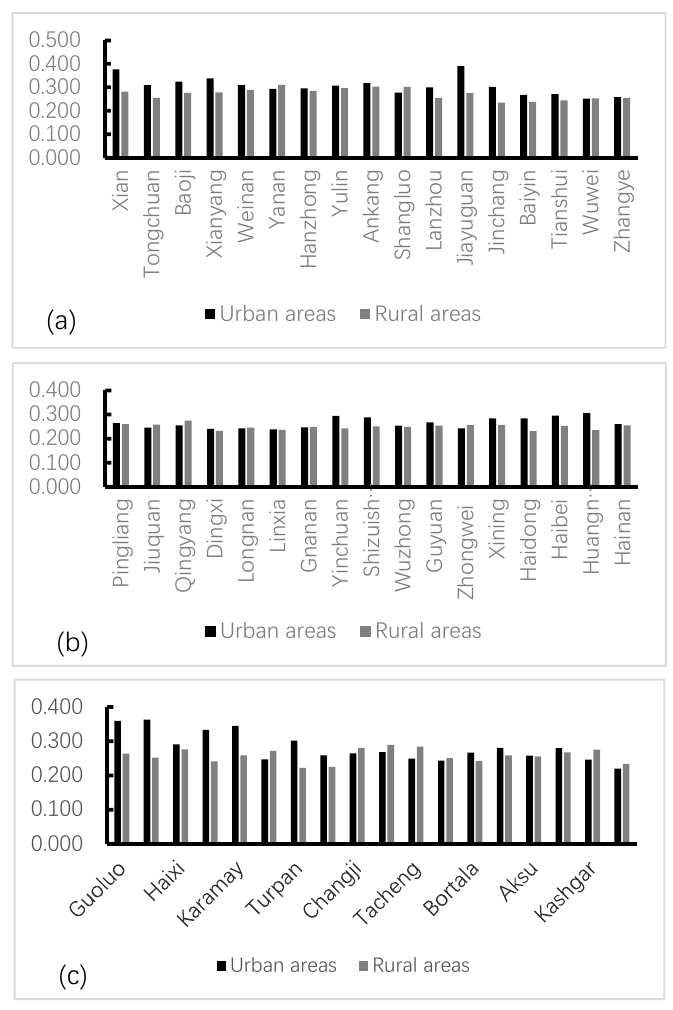
Figure 3. The urban and rural water poverty values ( a , b , c ) in northwest China. However, we have only analyzed the temporal changes of urban and rural water poverty, respectively, and ignored the spatial correlation between urban and rural areas in this section. The improvement of urban and rural water poverty may be based on a competition or cooperation mechanism, and the former can promote the coordinated development of urban and rural water poverty. This is further discussed in the next section.